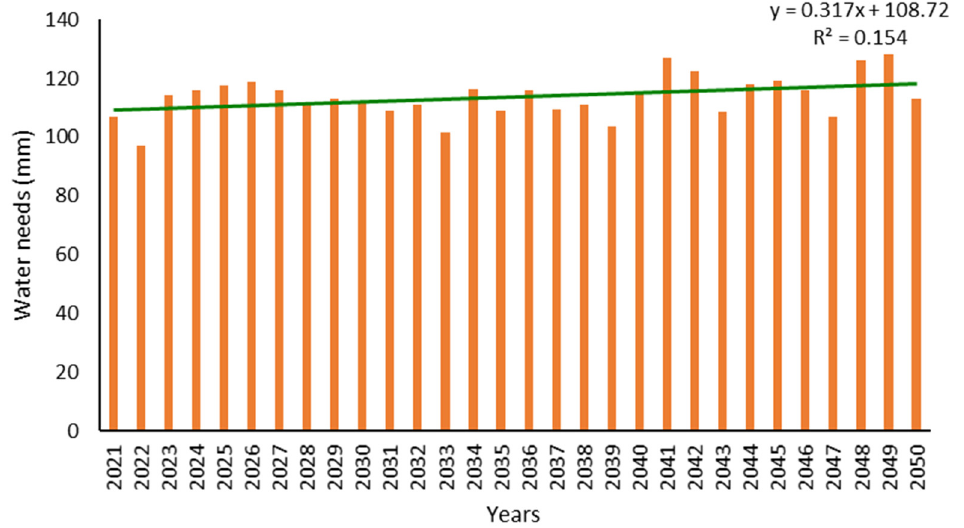
Figure 3. Time trend of grapevines’ water needs in August in the forecast years (2021–2050). Figures 4 and 5 show the grapevines’ daily and monthly water needs during the growing season in the reference and forecast years, respectively. The highest water needs of grapevines, both in the reference years and in the forecast years, were calculated in July. Slightly lower values of water needs were recorded in August, and even lower in June. The lowest water needs of grapevines were calculated in May and September. With the exception of May, both the daily and monthly water needs of grapevines in the forecast years were higher than in the reference years. In western (1981–2010) and central (1981–2020) Poland, the highest daily and monthly water needs of grapevines were